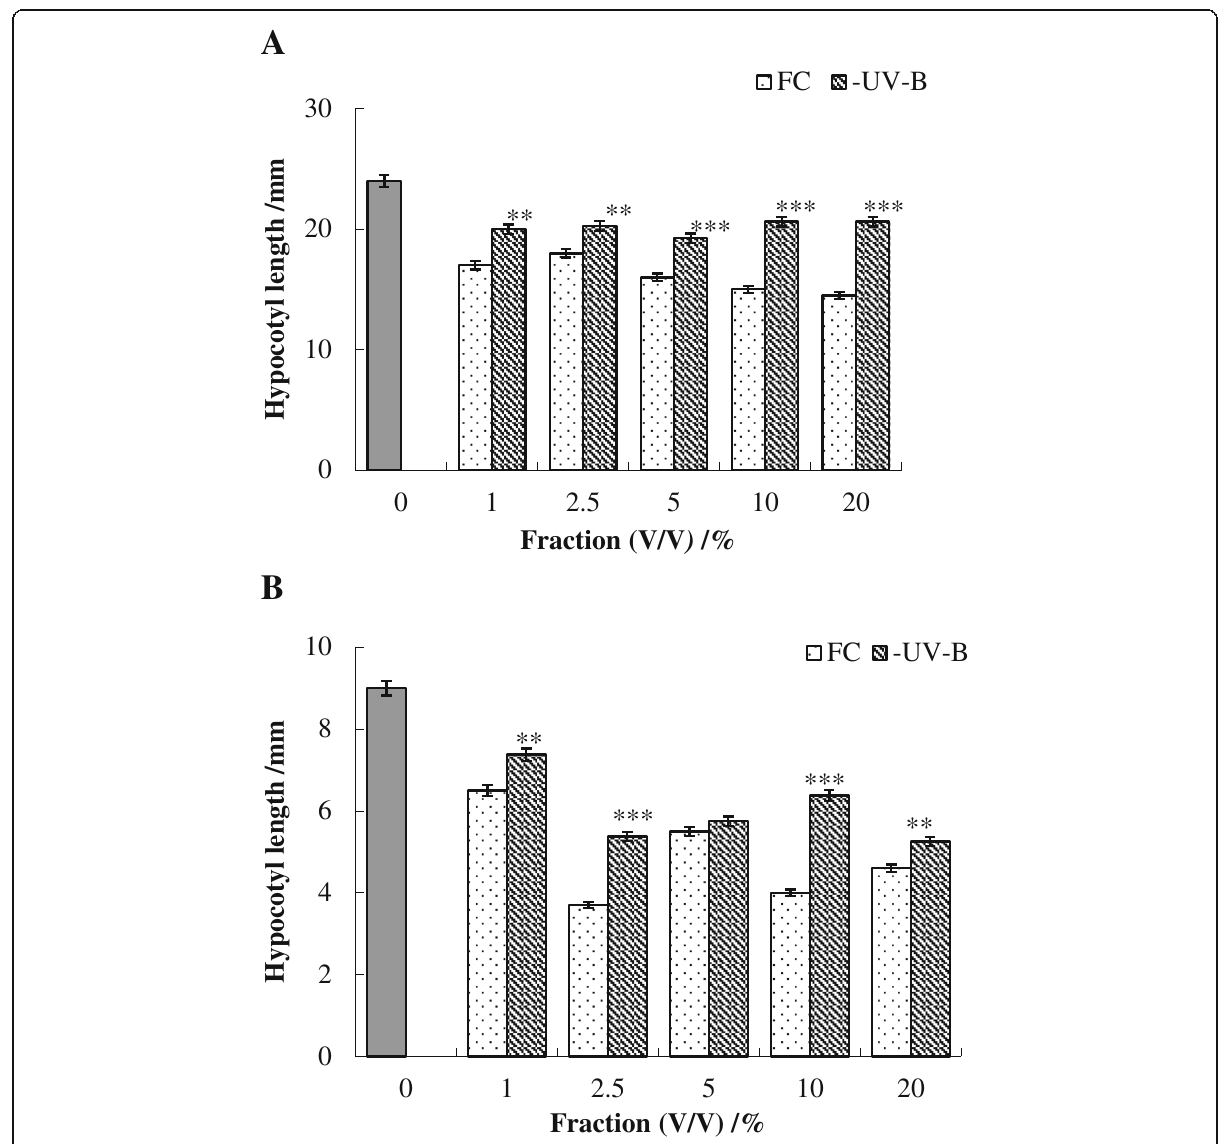
Fig. 8 Effect of ethyl acetate fraction obtained from internodal extracts of cotton var. Vikram on Amaranthus hypocotyl length in dark ( a ) and in light ( b ). The gray solid column indicates hypocotyl length of Amarathus seedlings in distilled water (0). The vertical bar indicates ±SE for mean. Values are significantly different at * P <0.05, ** P <0.01, *** P <0.001 from filter